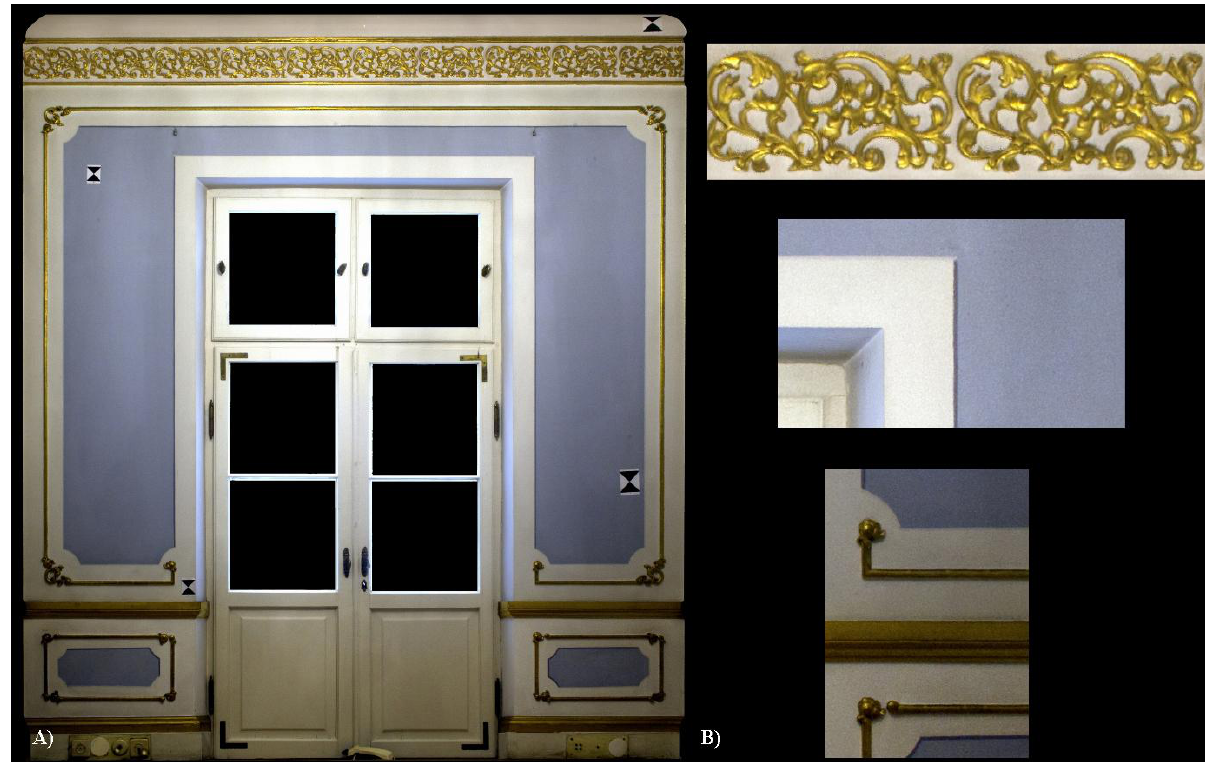
Figure 9. A) An orthoimage generated from integration of point clouds from TLS and image matching. B) Zooms show selected elements of the processed